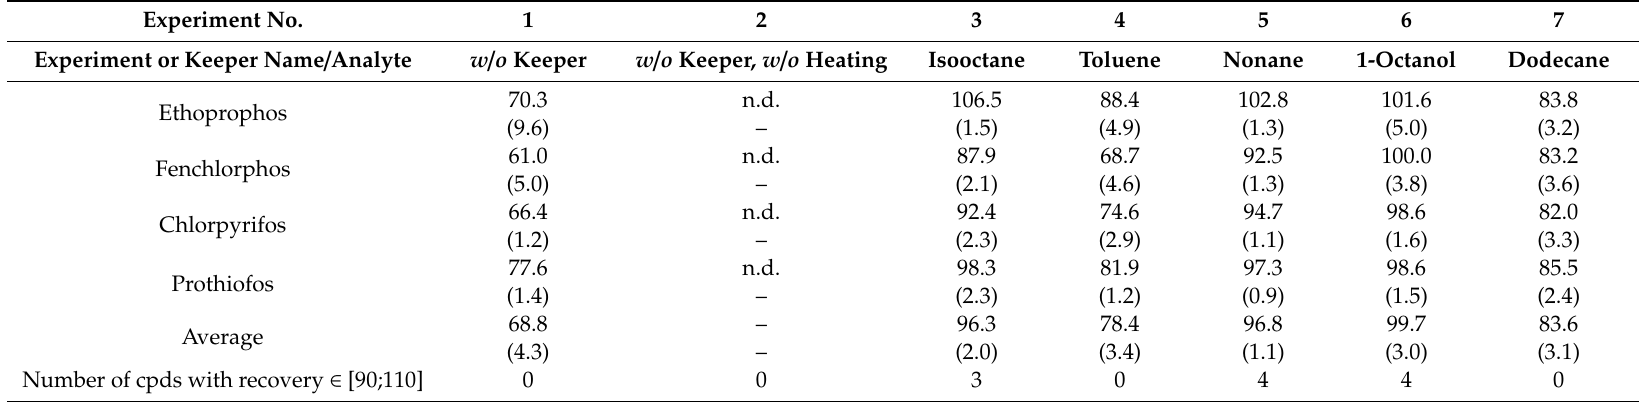
Table 4. Recoveries and RSDs (%) achieved in the organophosphorus pesticide (OPP) evaporation experiments. Experiment No.